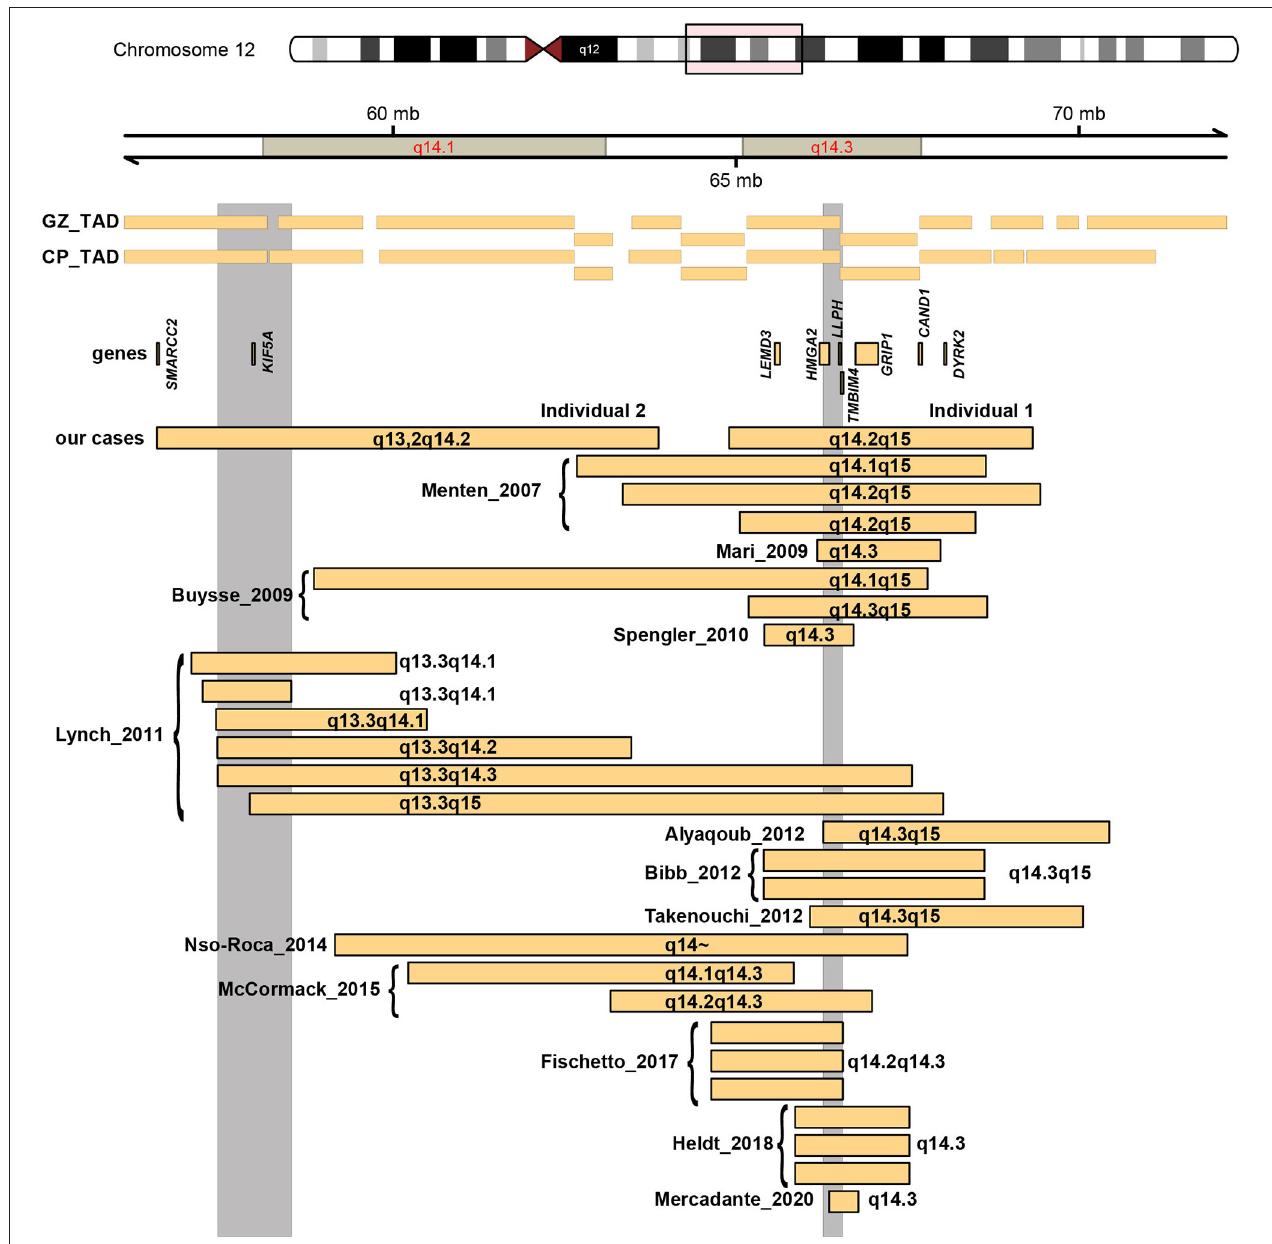
FIGURE 3 | As Figure 2 , but now zoomed-in at cluster 2 at 12q14.